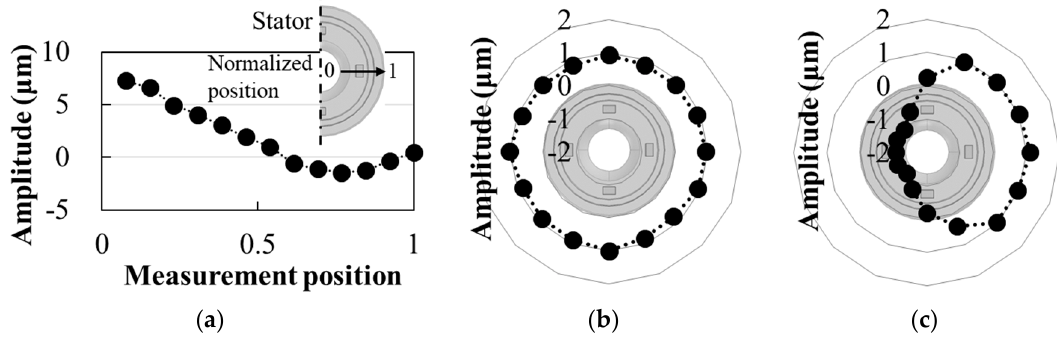
Figure 13. Vibration displacement measured on the prototype stator surface during each vibration mode. ( a ) B 21 -mode; ( b ) R 1 -mode; and ( c ) ((1,1))-mode.